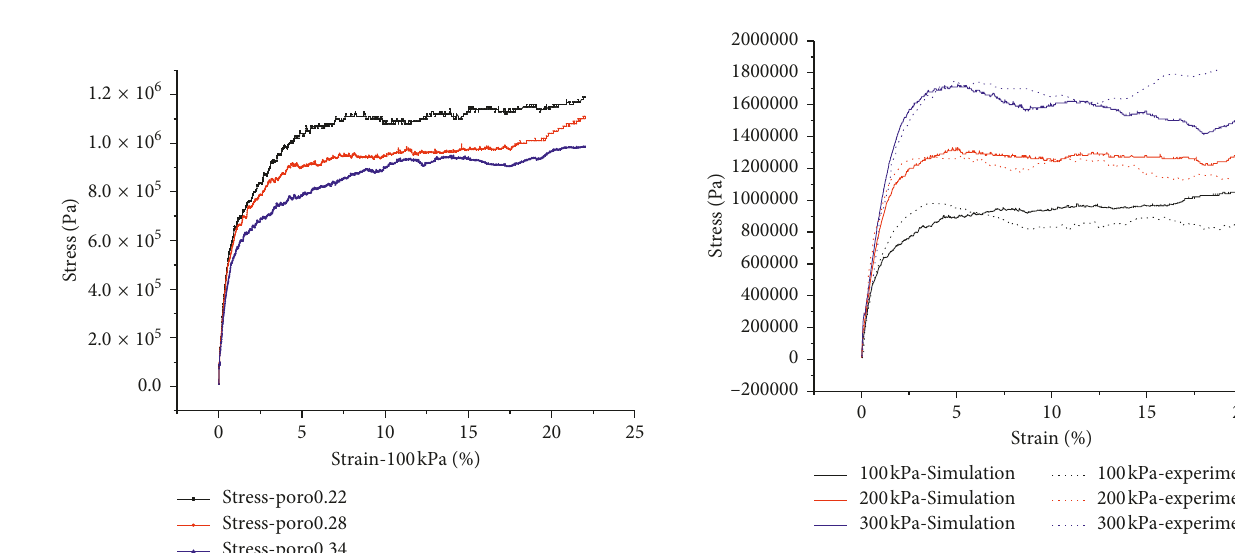
Figure 7: Stress-strain of different normal stiffness values.